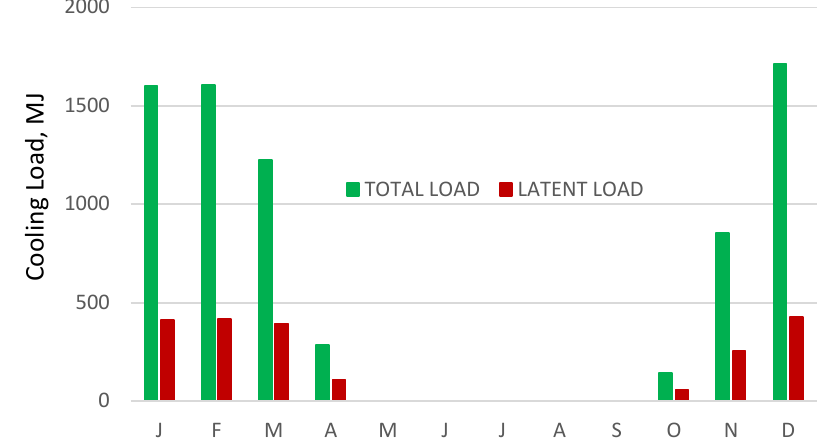
Figure 15. Monthly total and latent cooling demands for the house (economy cycle mode).